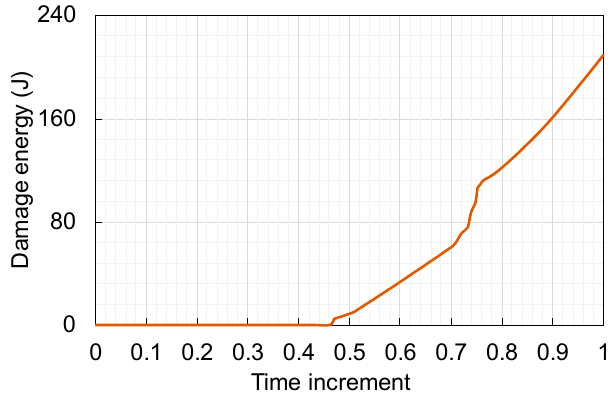
Figure 7. Damage dissipation energy for the extended finite element method model (T2).